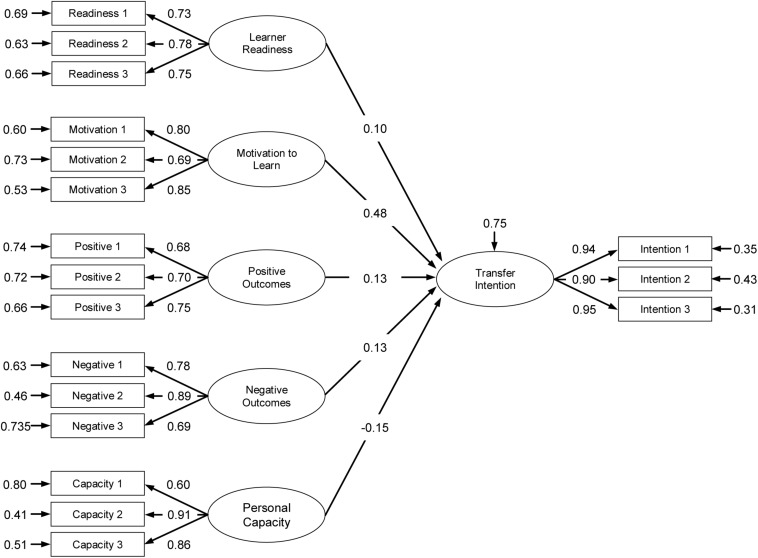
Measurement and structural model parameter estimates of transfer context: Work.